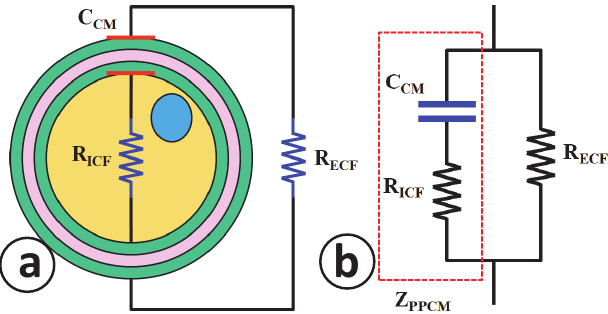
Fig.4: Equivalent electrical circuit modeling of animal cells. (a) An isolated animal cell and the electrical equivalence of the intracellular fluids (ICF), extracellular fluids (ECF) and the cell membrane (CM). (b) An equivalent electrical circuit model of an isolated animal cell surrounded by